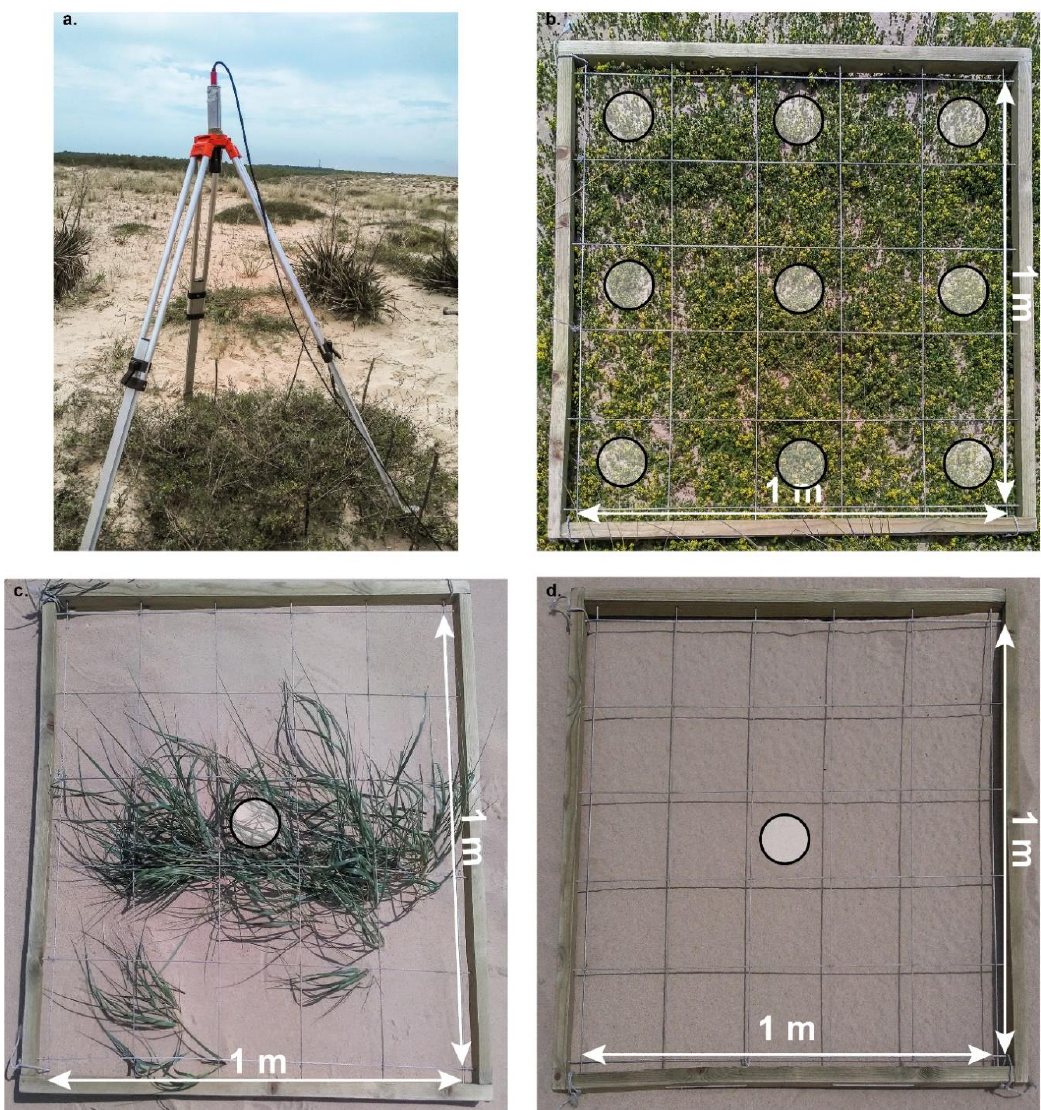
Figure 3. Photos taken at the study site on 25 June 2019, showing ( a ) the deployment mode of radiance TriOS-RAMSES sensor on tripod 1.2 m and the heterogeneity of the optical signal of vegetation and sand covers over unit area of 1 m 2 , requiring an adaptive sampling strategy for ( b ) large vegetation patches (example of Galium arenarium ); ( c ) plant species with isolated individuals, or sparse cover